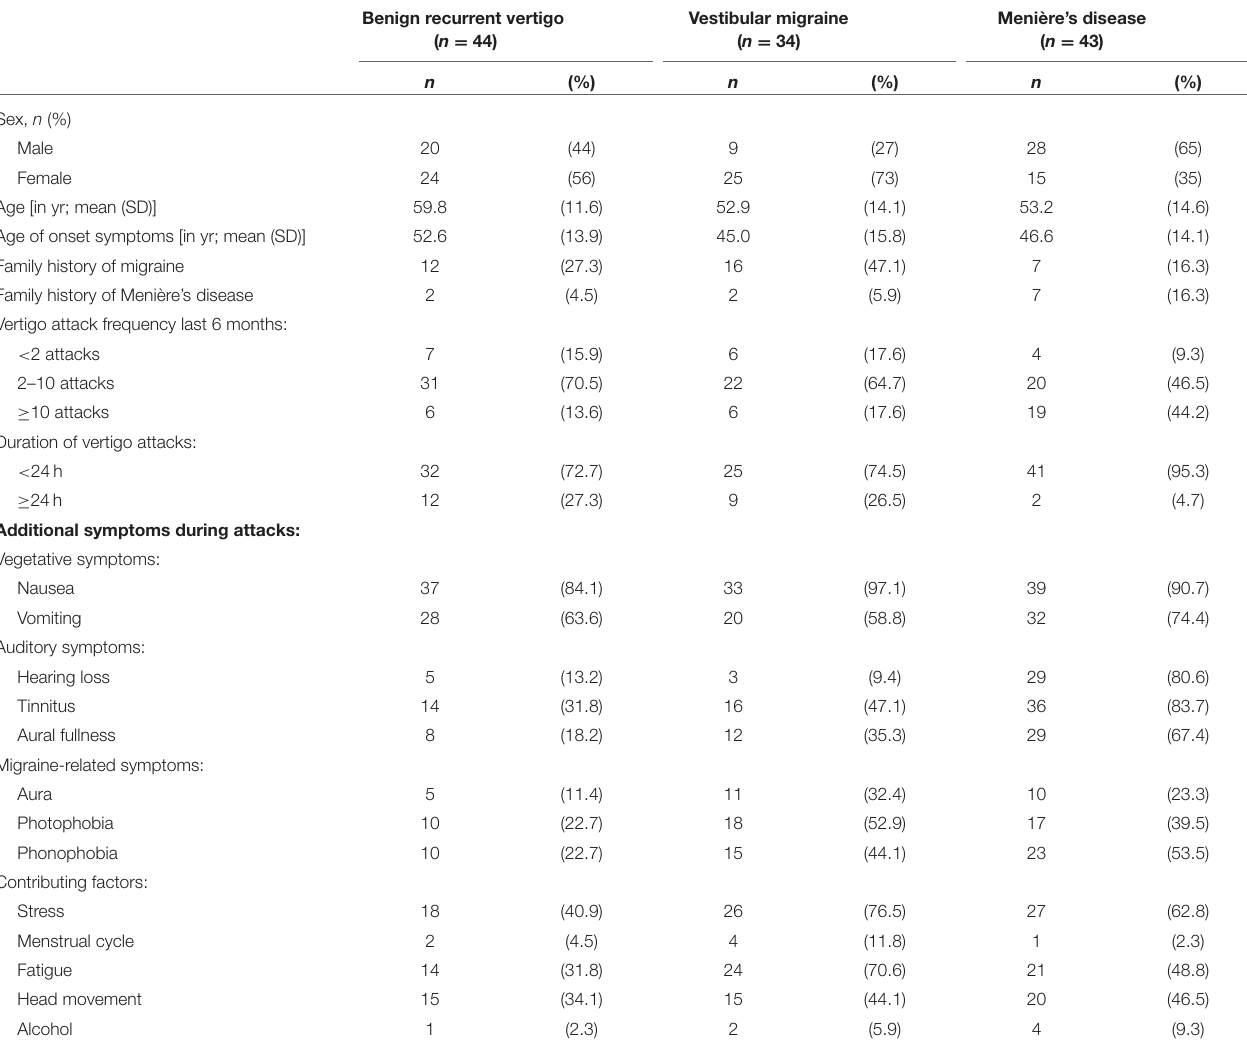
TABLE 2 | Demographic and clinical characteristics of the three diagnosis groups at initial presentation.